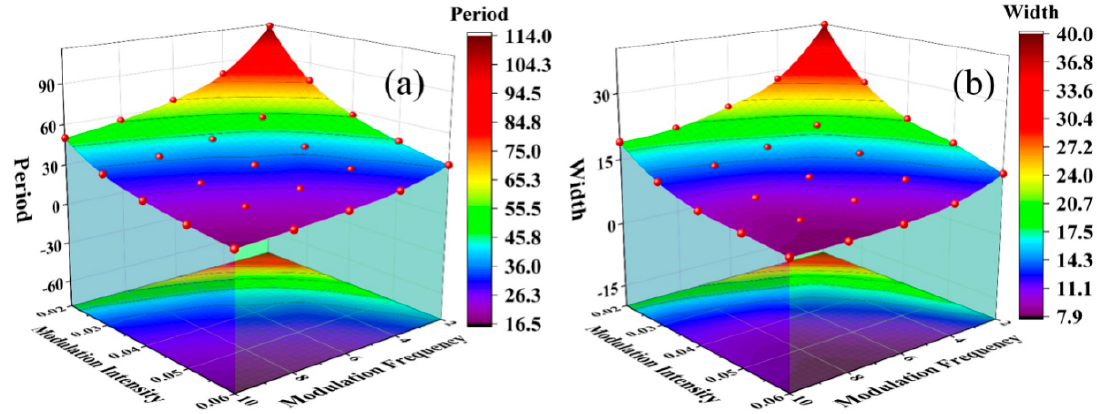
Figure 7. When x 0 = 1, ϕ 0 = 2 π /3, the influence of different modulation intensities and modulation frequencies on the ( a ) period and ( b ) width of the breathing soliton in the periodic potential optical lattice.